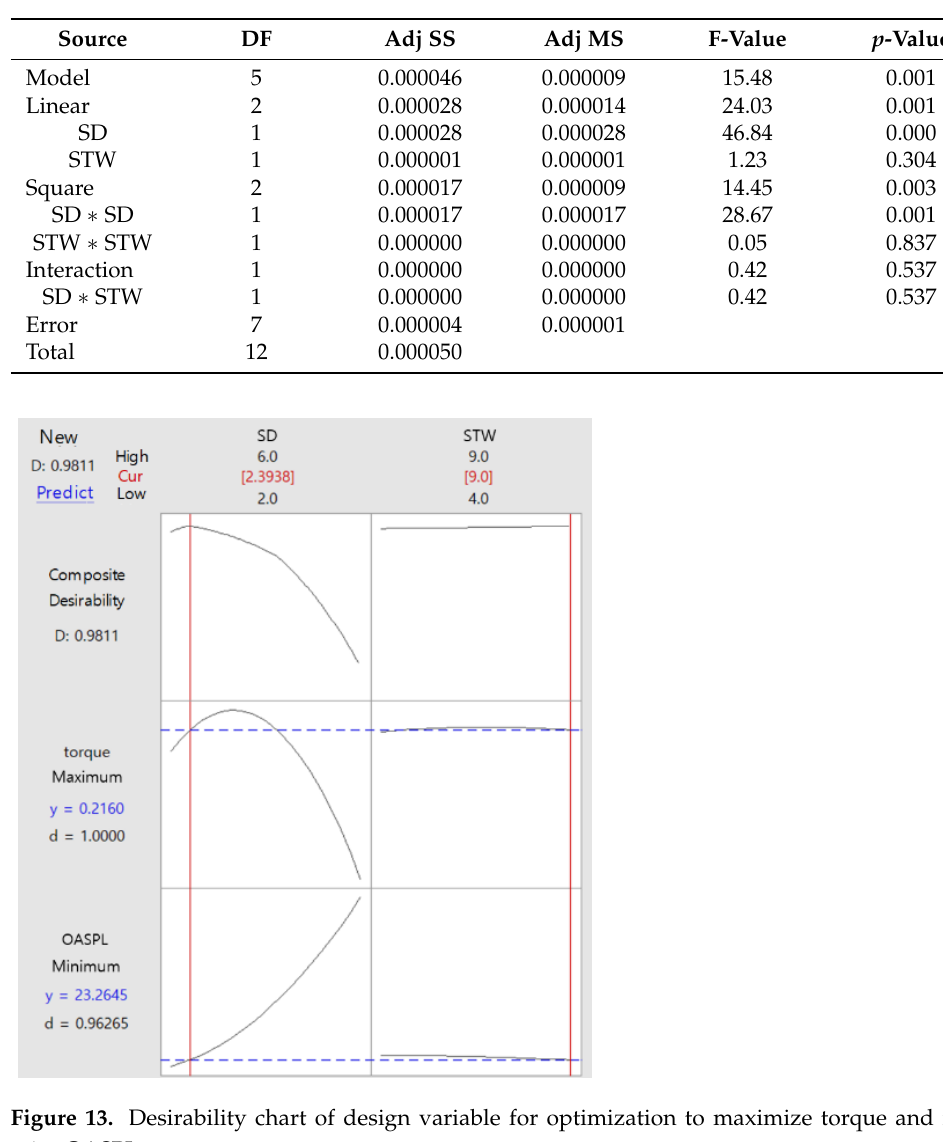
Figure 14. Comparison of the standard and optimal models of SPL.